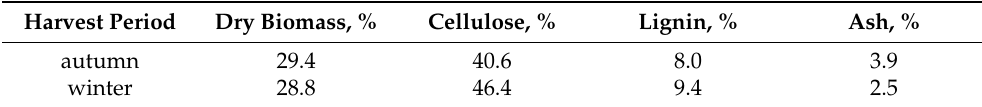
Table 1. Dependence of cellulose and lignin content on the harvest period. Harvest Period Dry Biomass, % Cellulose, % Lignin, % Ash, % autumn 29.4 40.6 8.0 3.9 winter 28.8 46.4 9.4